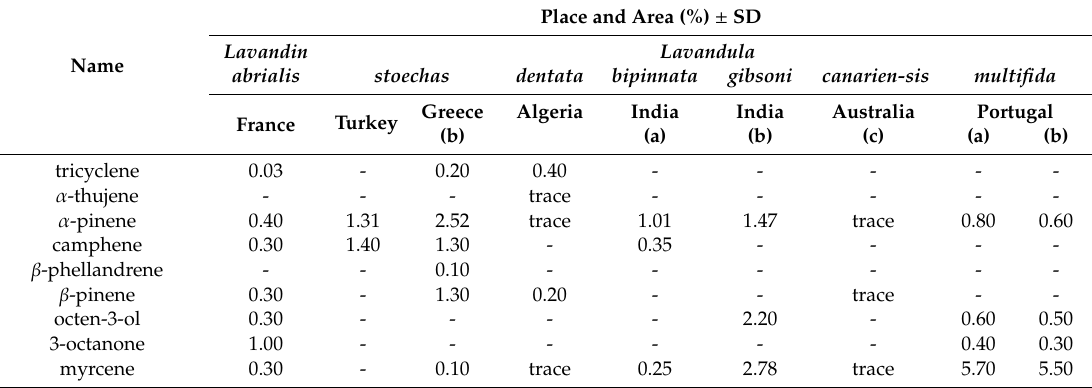
Table 2. The components of other lavender oils described in the